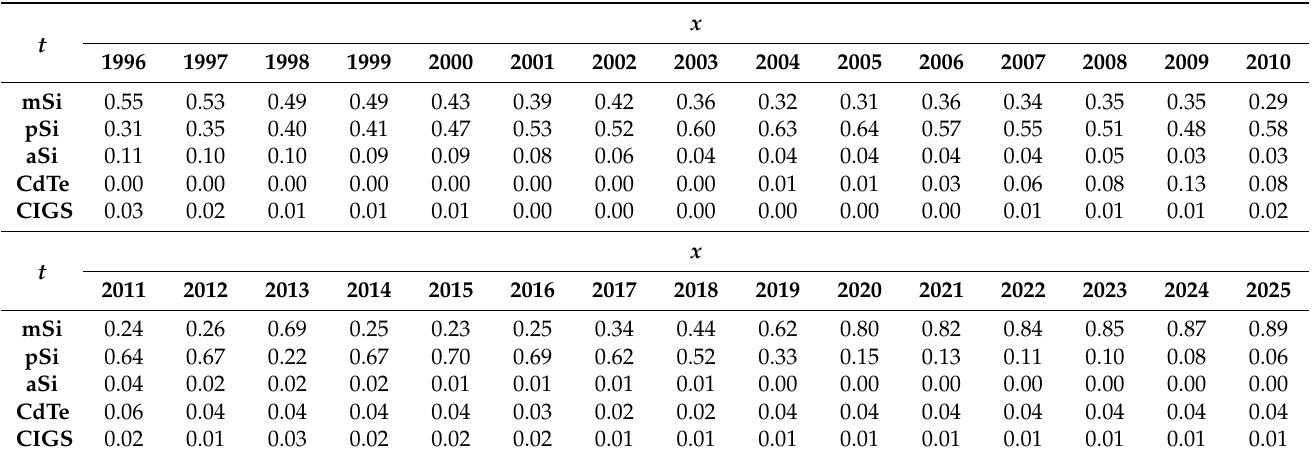
Table 6. Photovoltaic technology shares by annual capacity installed.